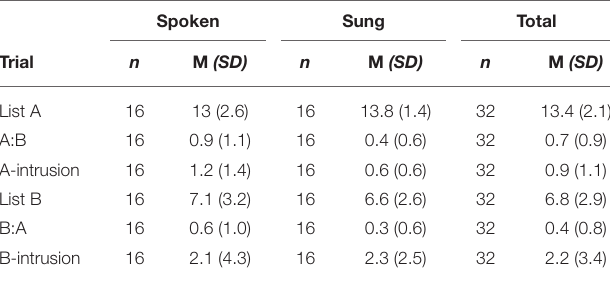
TABLE 4 | Recognition scores for words correctly identified, intrusions, and